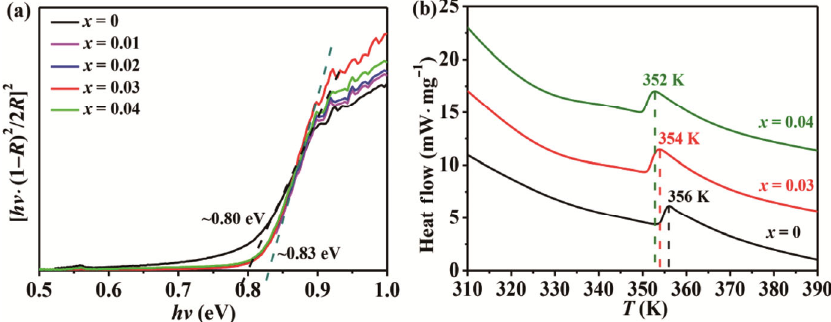
Fig. 2 (a) Normalized optical absorption versus photon energy ( hv ) and (b) DSC for the hot-pressed Ag 8 Sn 1+ x Se 6 − 2 x Br 2 x